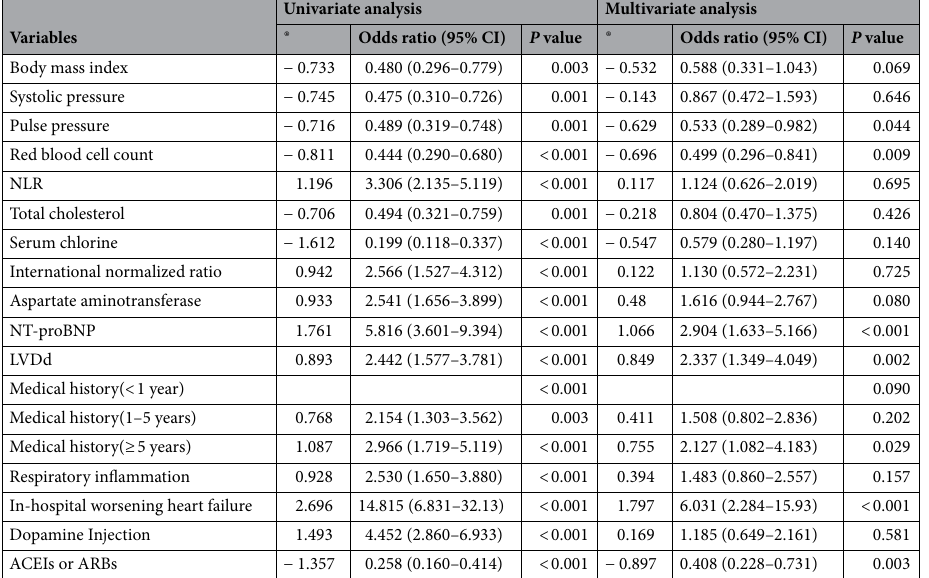
Table 2. Results of Logistic regression. . NLR neutrophil to lymphocyte ratio, NT-proBNP N terminal pro B type natriuretic peptide, LVDd left ventricular end diastolic dimension, ACEIs angiotension converting enzyme inhibitors, ARBs angiotensin receptor blockers, CI confidence interval. ® is the regression